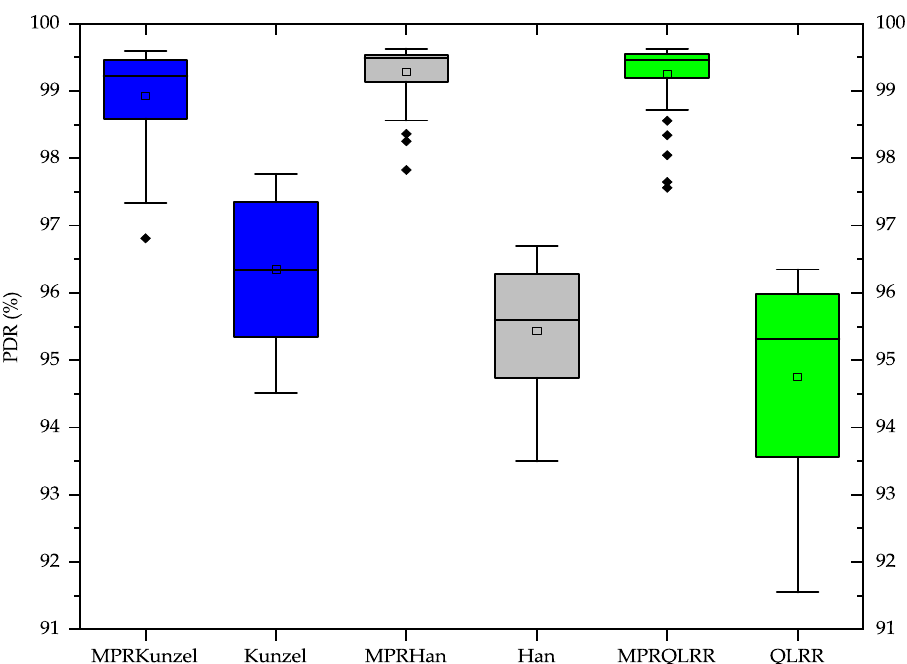
Figure 11. Packet delivery ratio (PDR) performance comparison.